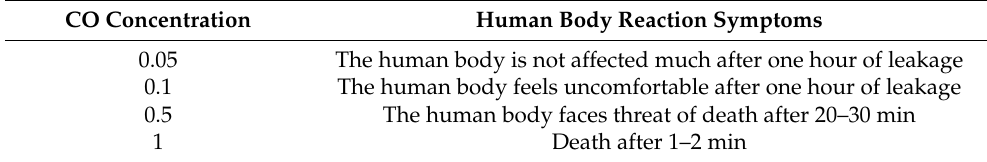
Table 4. The effect of CO on the human body.